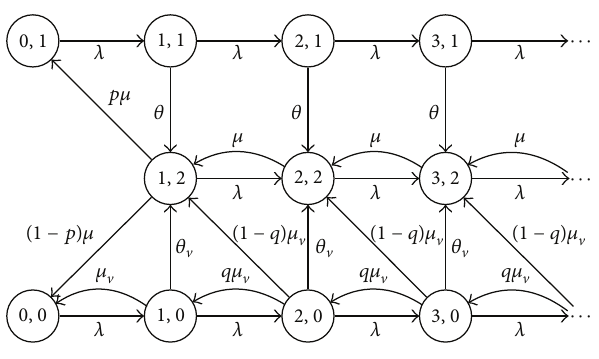
Figure 1: State transition